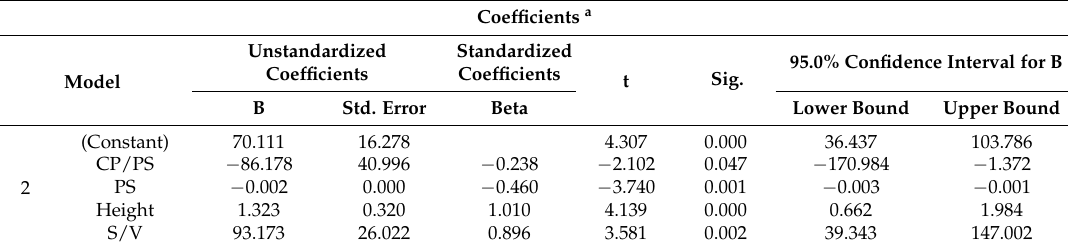
Table 16. Coefficients of regression model for Heraklion urban block load